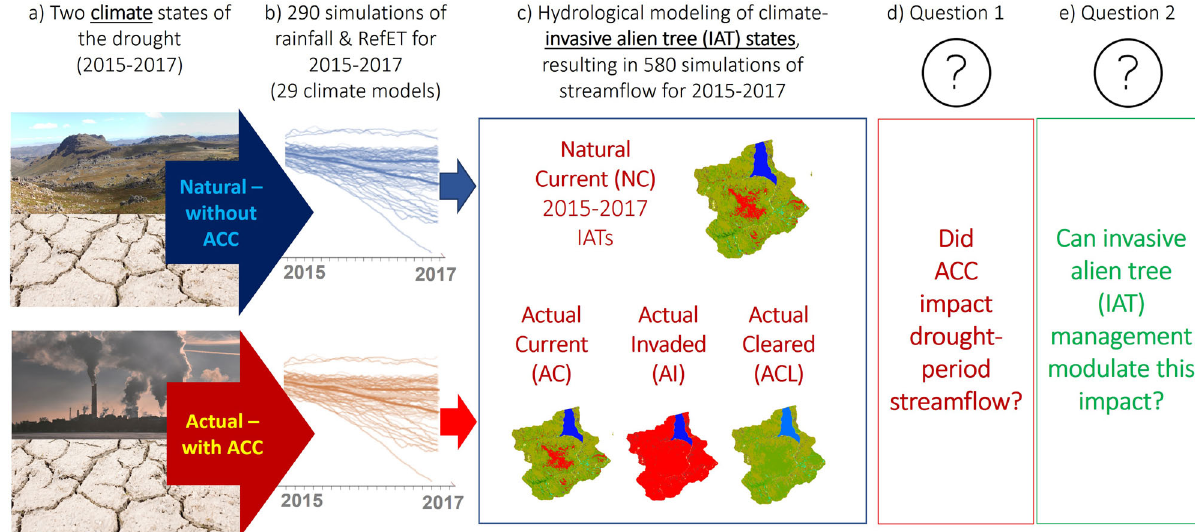
Fig. 1 Modelling set-up for joint multi-model event attribution (Climate and IAT states) applied in this paper. The joint multi-model event attribution framework, showing one catchment as an example: the Upper Berg, South Africa. a , b Illustrates the simulations of climate variables for the Cape Town ‘ Day Zero ’ Drought under today ’ s climate (Actual) and a counterfactual climate (Natural) with human-induced drivers removed, c shows the three different invasive alien tree (IAT) states resulting in hydrological modelling of four climate-IAT states: Natural Current (NC), Actual Current (AC), Actual Invaded (AI), Actual Cleared (ACL). This enabled us to determine the percentage of Natural Climate drought-period stream fl ow realised under the Actual Climate with the observed levels of IATs (as described in ref. 67 ) that were present during the drought (Current Landscape); and the extent to which management of IATs could have modulated any reductions or changes in drought-period stream fl ow due to anthropogenic climate change ( d , e